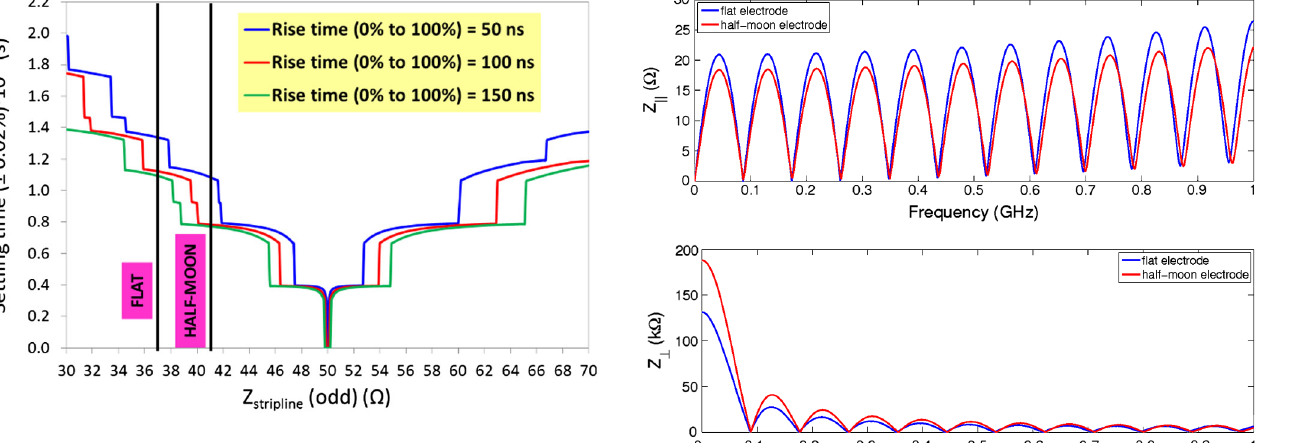
(red).FIG. 10. Settling time of the stripline voltage pulse as a function of odd mode stripline impedance for different 0% to 100% rise times of the output pulse of the inductive adder. The inductive adder, transmission line, and terminating resistor impedances are 50 Ω